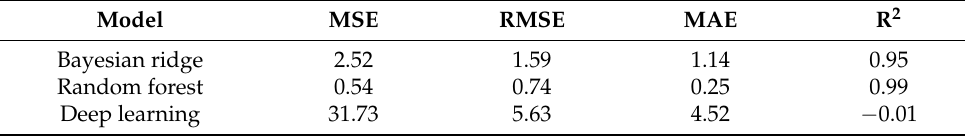
Table 2. Comparison of models’ prediction accuracy.